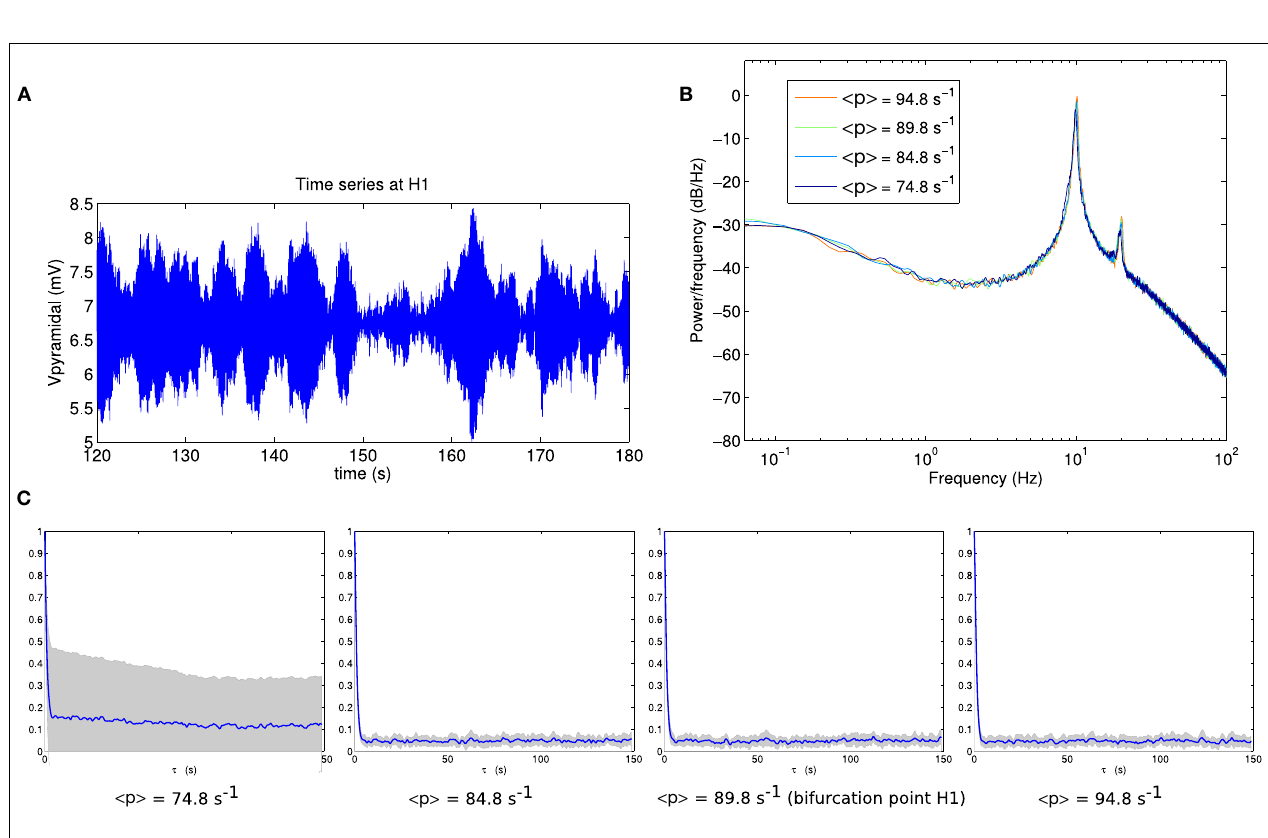
< p > = 84.8s − 1 ), at the bifurcation point H1 (< p > = 89.8s − 1 ) and beyond the bifurcation point (< p > = 94.8s − 1 ).The line indicates the mean over 16 trials and the gray area indicates one standard